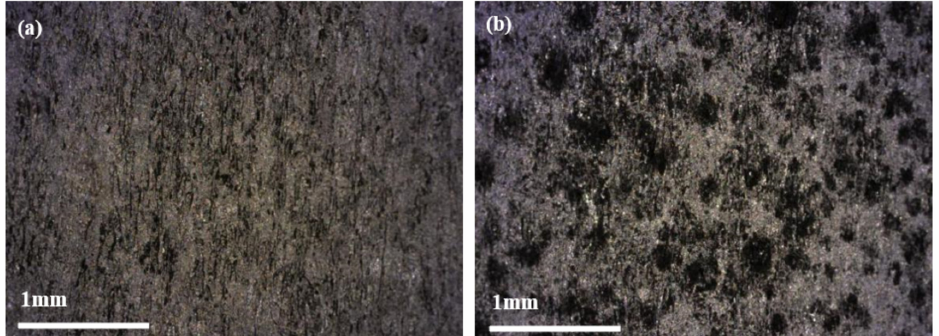
Figure 13. Micromorphology of sample surface magnified by 100 × under optical microscope at different test cycles: ( a ) 4 h, ( b ) 12